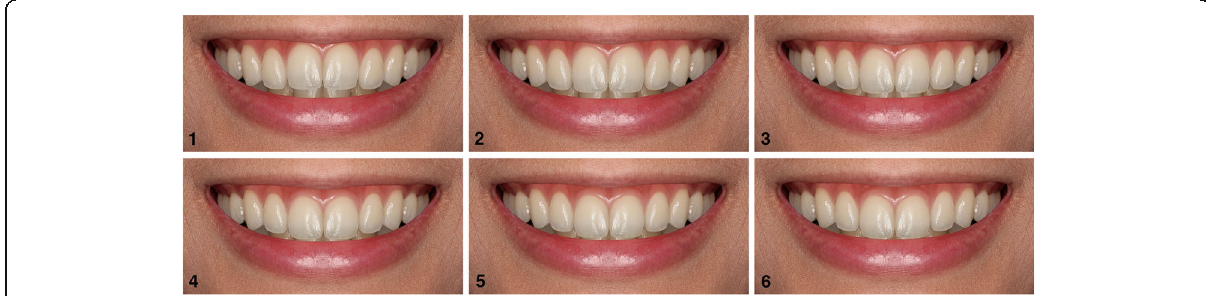
Fig. 1 Altered incisal edge position of the maxillary central incisors in 0.5-mm increments. 1 0.5 mm intruded; 2 0 mm extruded; 3 0.5 mm extruded; 4 1.0 mm extruded; 5 1.5 mm extruded; and 6 2.0 mm